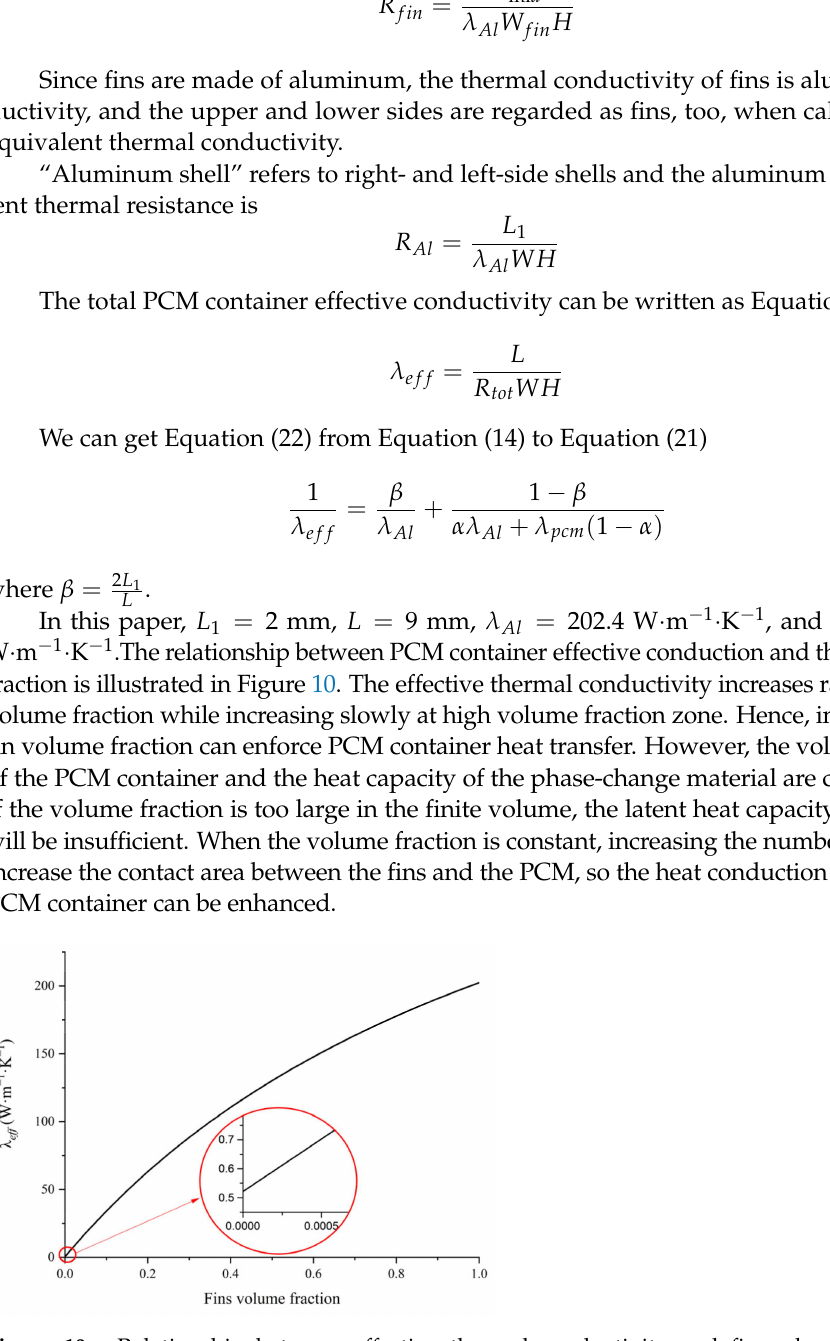
Figure 10. Relationship between effective thermal conductivity and fin volume fraction of PCM